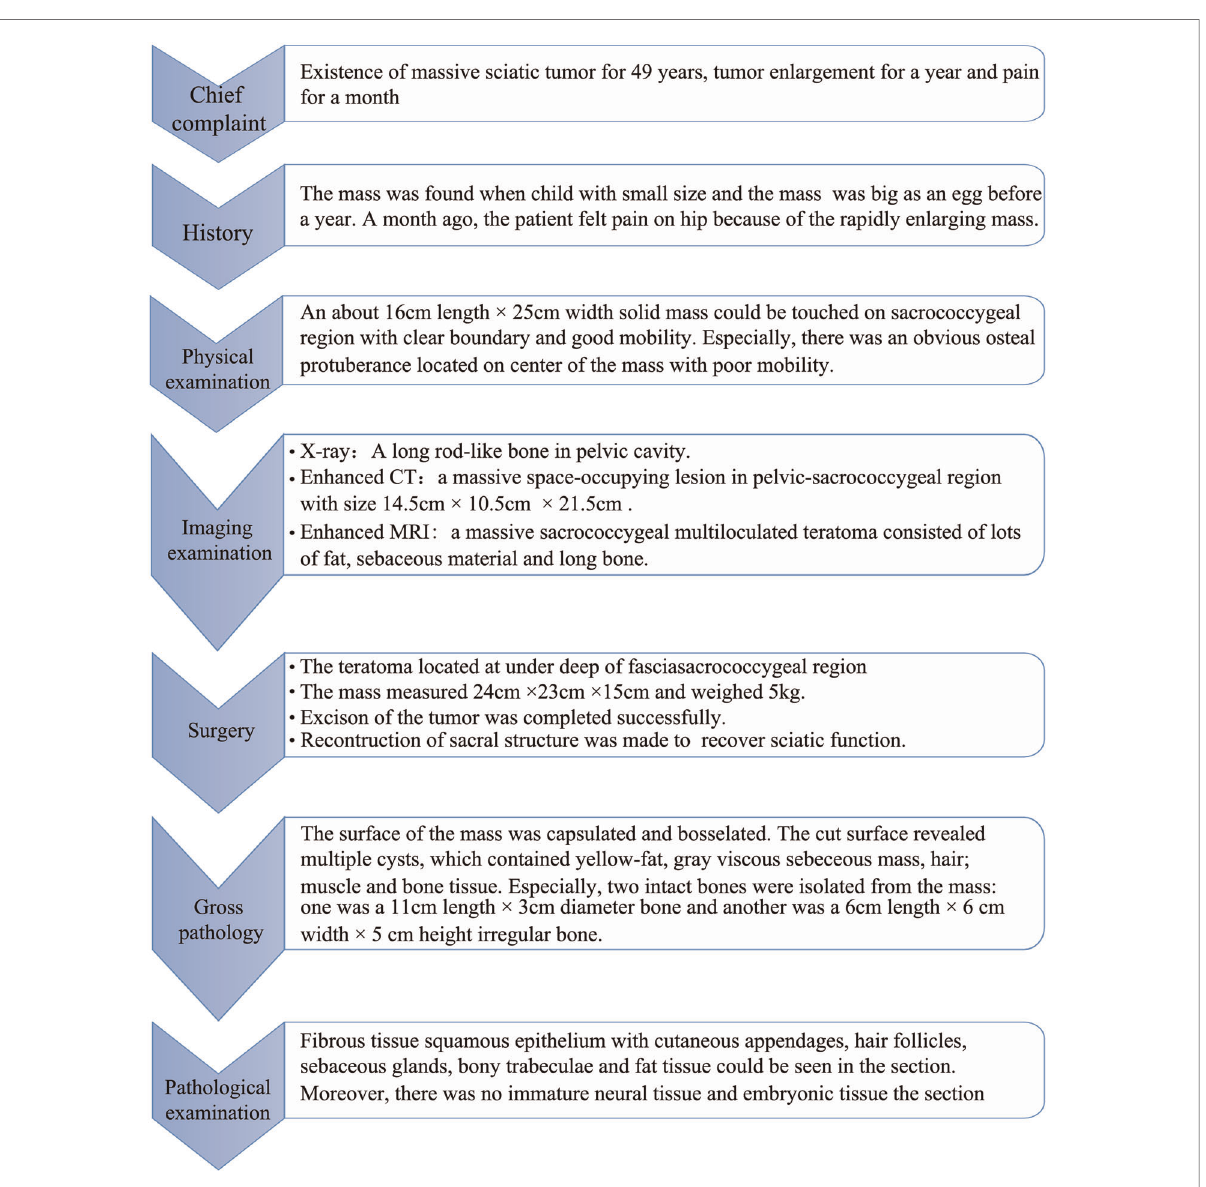
FIGURE 4 The therapeutic course of the patient. The current case report is presented based on this sequence of